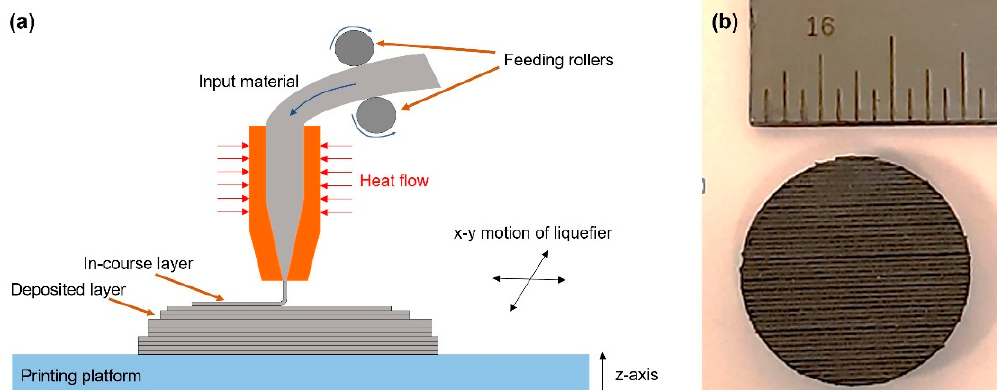
Figure 1. ( a ) Schematic representation of a (FFF) process (adapted from Ref. [22]) and ( b ) 3D printed puck used to fabricate test samples (ruler units are in inches).